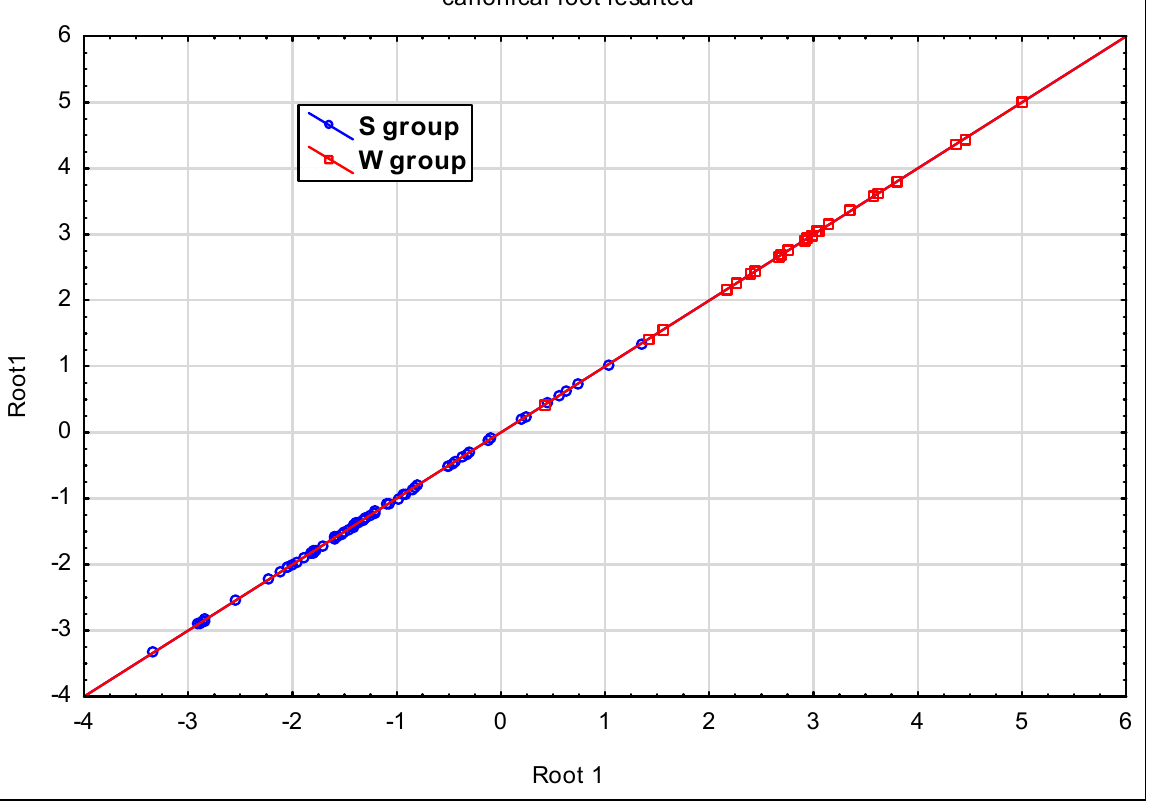
Figure 3. The differentiation of P. cactorum host-specific groups, documented by the canonical roots of discriminant analysis based on the results of all three analyses. S—isolates from strawberry plants and W—isolates from woody plants.